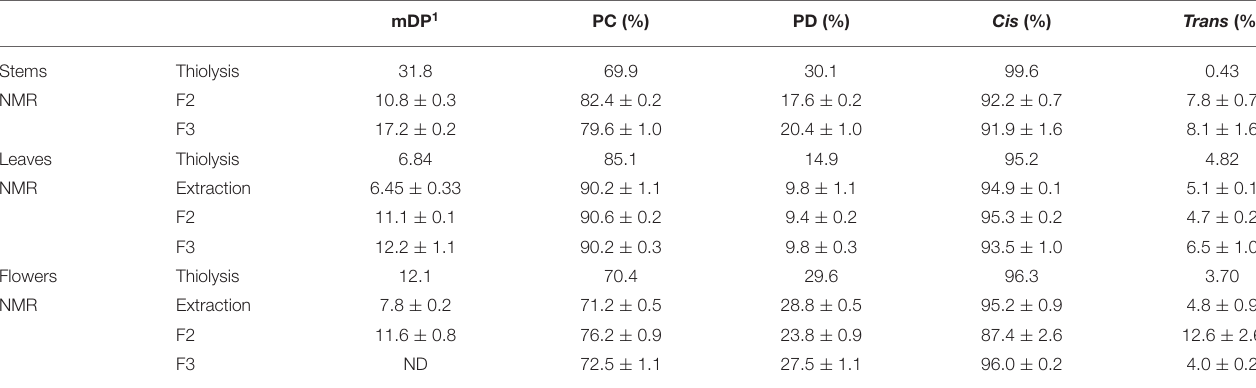
TABLE 4 | Comparison of thiolysis and NMR data for the composition of CT in stems, leaves, and flowers of PPC ( Dalea purpurea Vent) harvested at EF